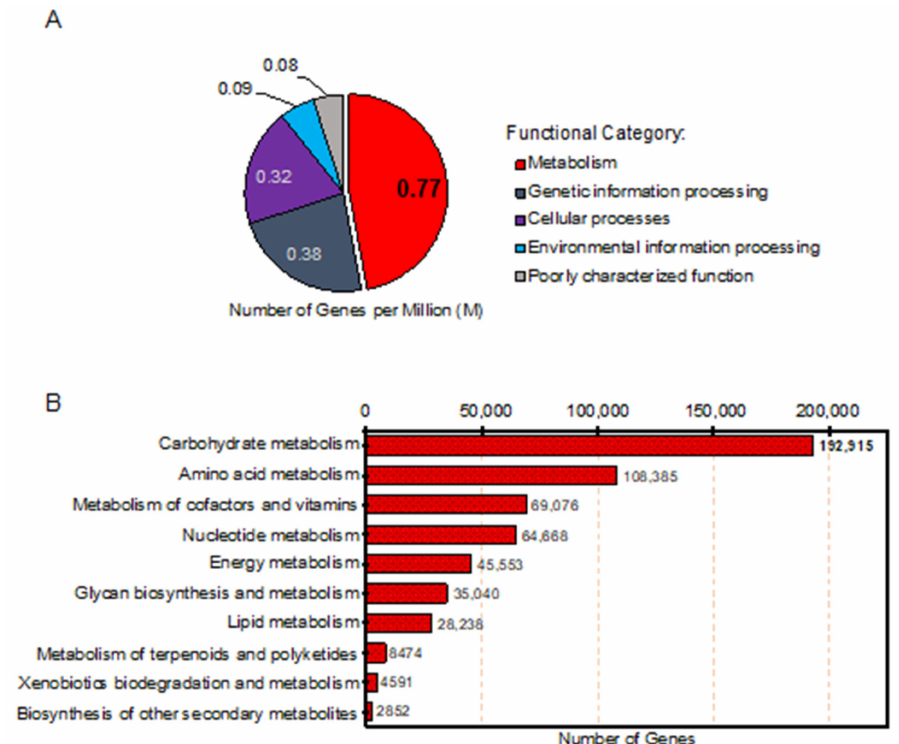
Figure 3. Number of genes involved in metabolic functions of Thai gut microbiome. ( A ) The distribution of genes across the five main functional categories, and ( B ) The number of genes involved in metabolic functions across the different metabolic